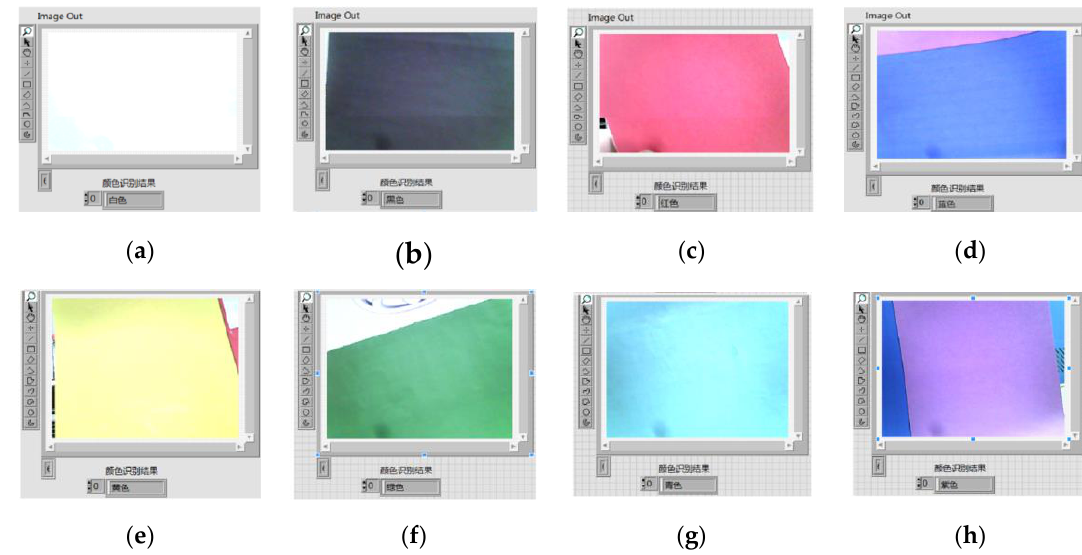
Figure 6. Color recognition results: ( a ) white, ( b ) black, ( c ) red, ( d ) blue, ( e ) yellow, ( f ) green, ( g ) cyan, and ( h ) purple.